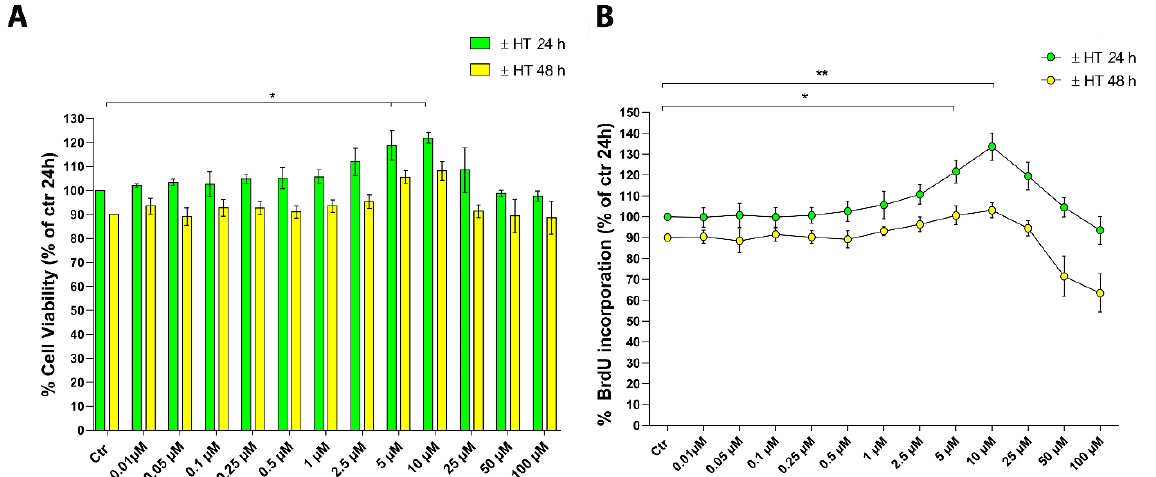
Figure 1. Evaluation of 3-hydroxytyrosol (HT) effect in HaCaT keratinocytes. Cells were cultured in the presence of the indicated HT concentrations (0–100 µ M) for 24 or 48 h before the MTT assay ( A ) or BrdU incorporation ( B ). Results are expressed as mean ( ± SD) and are representative of four independent experiments carried out in triplicate. Data are reported as percentage vs. control (untreated cells at 24 h or 48 h) (2-way ANOVA, * p < 0.05, ** p < 0.01 vs. control).